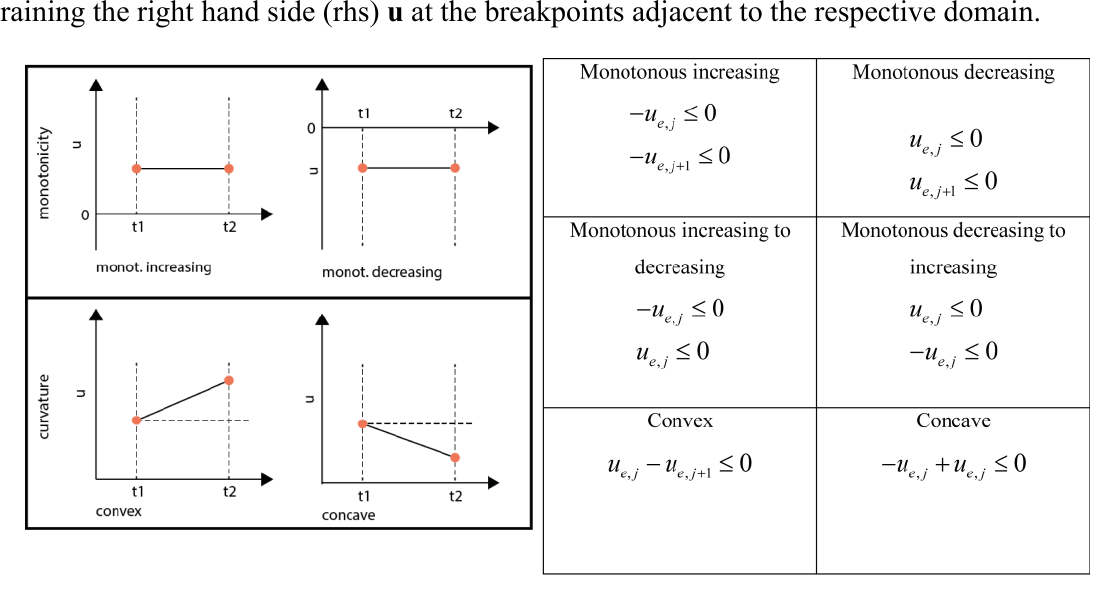
Figure 6. Inequality equations for the different shape